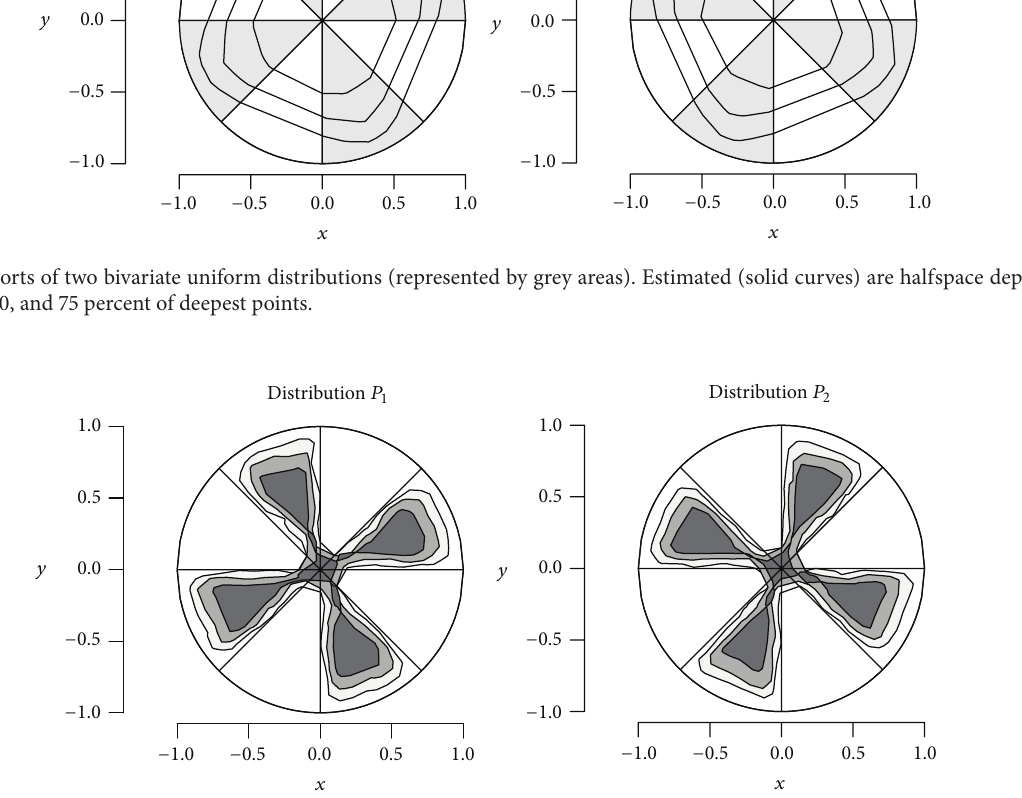
Figure 2: Estimated central regions of 25, 50, and 75 percent of deepest points when considering generalized (band) halfspace